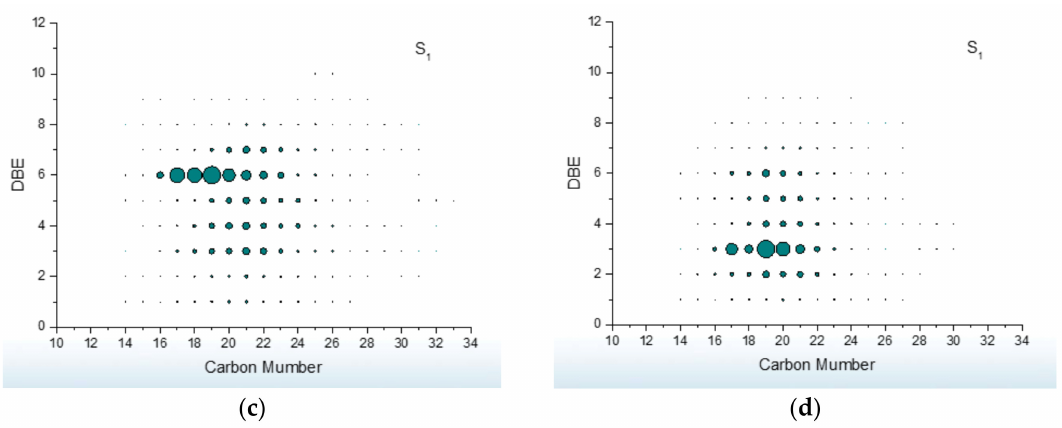
Figure 5. The FT-ICR MS distribution of thioether sulfur: ( a ) WLT, ( b ) HCT, ( c ) QZT, and ( d ) HLT.